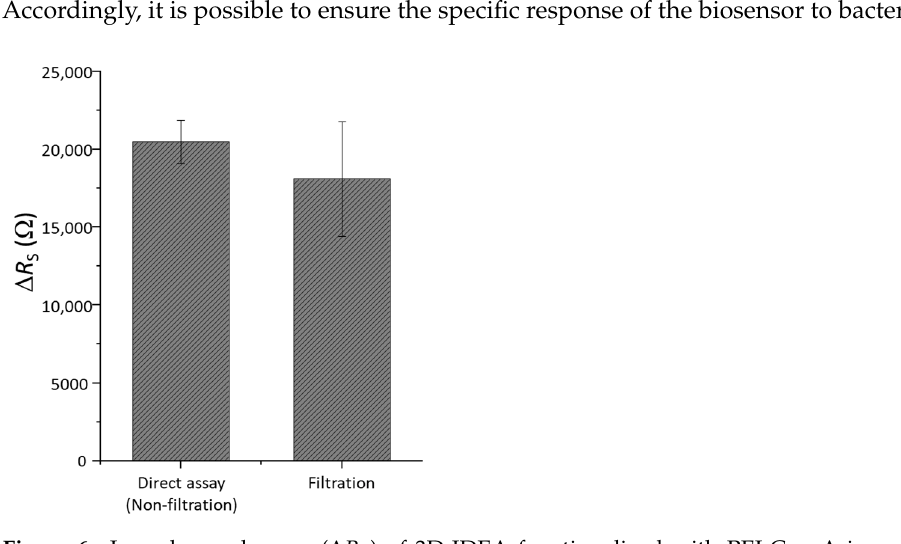
Figure 6. Impedance changes ( ∆ R S ) of 3D-IDEA functionalized with PEI-Con A in a standard detection assay and with cyanobacteria recovered after the filtration process.